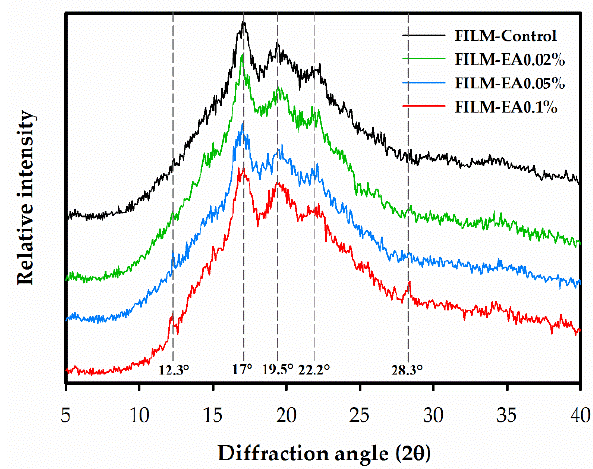
Figure 3. X-ray diffractograms of apple starch films without ellagic acid (FILM-Control) and with ellagic acid (EA) added to 0.02% (FILM-EA0.02%), 0.05% (FILM-EA0.05%) and 0.1% (FILM-EA0.1%).